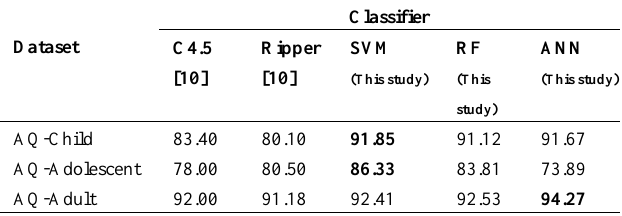
Table 6. The result of classifier